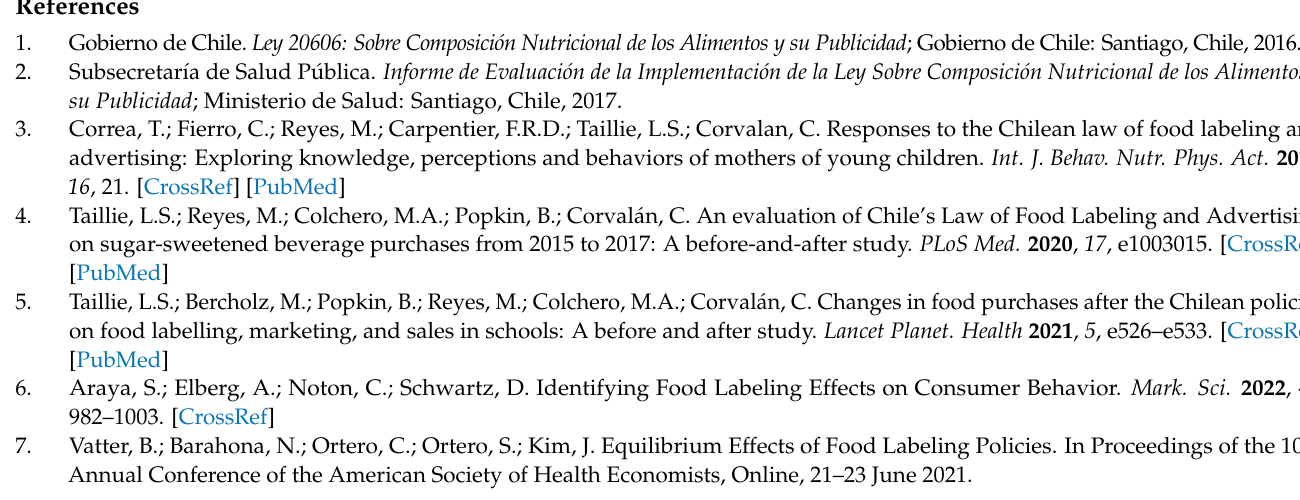
Table S6: Marginal effect of the intervention on the volume purchased and trend before and after the intervention by label and by SES level; Table S7: Marginal effect of the intervention on the volume purchased and trend before and after the intervention by "life cycle"; Table S8: Marginal effect of the intervention on the monthly volume purchased in labelled products and trends before and after the intervention by type of label; Table S9: Marginal effect of the intervention on the volume purchased and trend before and after the intervention by type of label and by SES level; Table S10: Marginal effect of the intervention on the volume purchased and trend before and after the intervention by label and by life